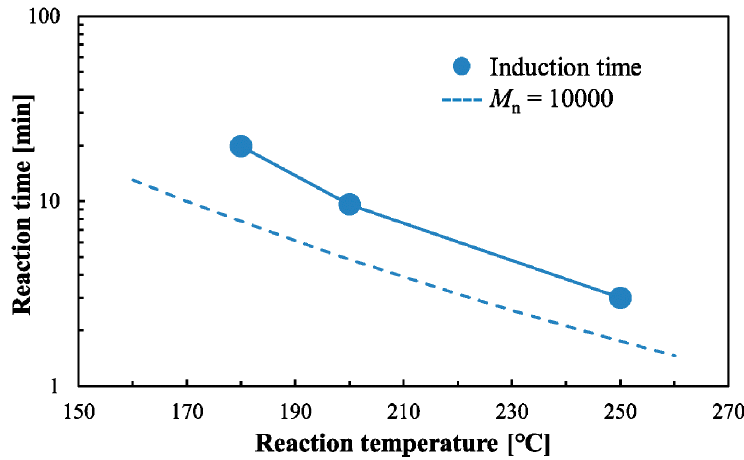
Figure 9. Induction time for the water-soluble content (WSC) ratio and reaction time for decreasing of M n under M n = 10,000 plotted against reaction temperature.